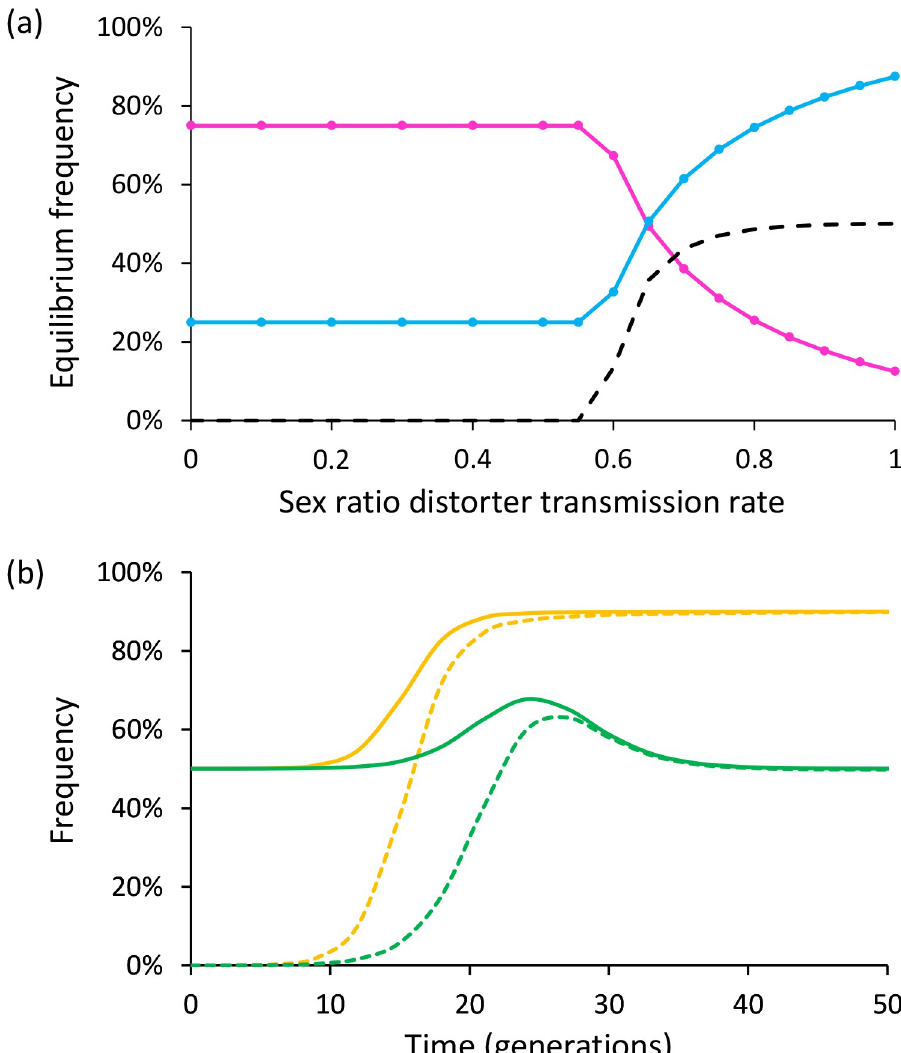
Fig 4. Evolutionary consequences of a cytoplasmic sex ratio distorter at the population level. (a) Equilibrium frequencies of X chromosome (pink line), Y chromosome (blue line), and distorter (dashed line), according to distorter transmission rate in XX and XY females (YY females do not transmit the distorter). (b) Evolution of the frequencies of females (solid lines) and individuals carrying the distorter (dashed lines) through time, with a distorter transmission rate of 0.9. Green: YY females do not transmit the distorter (only XX and XY females do); orange: all females transmit the distorter.